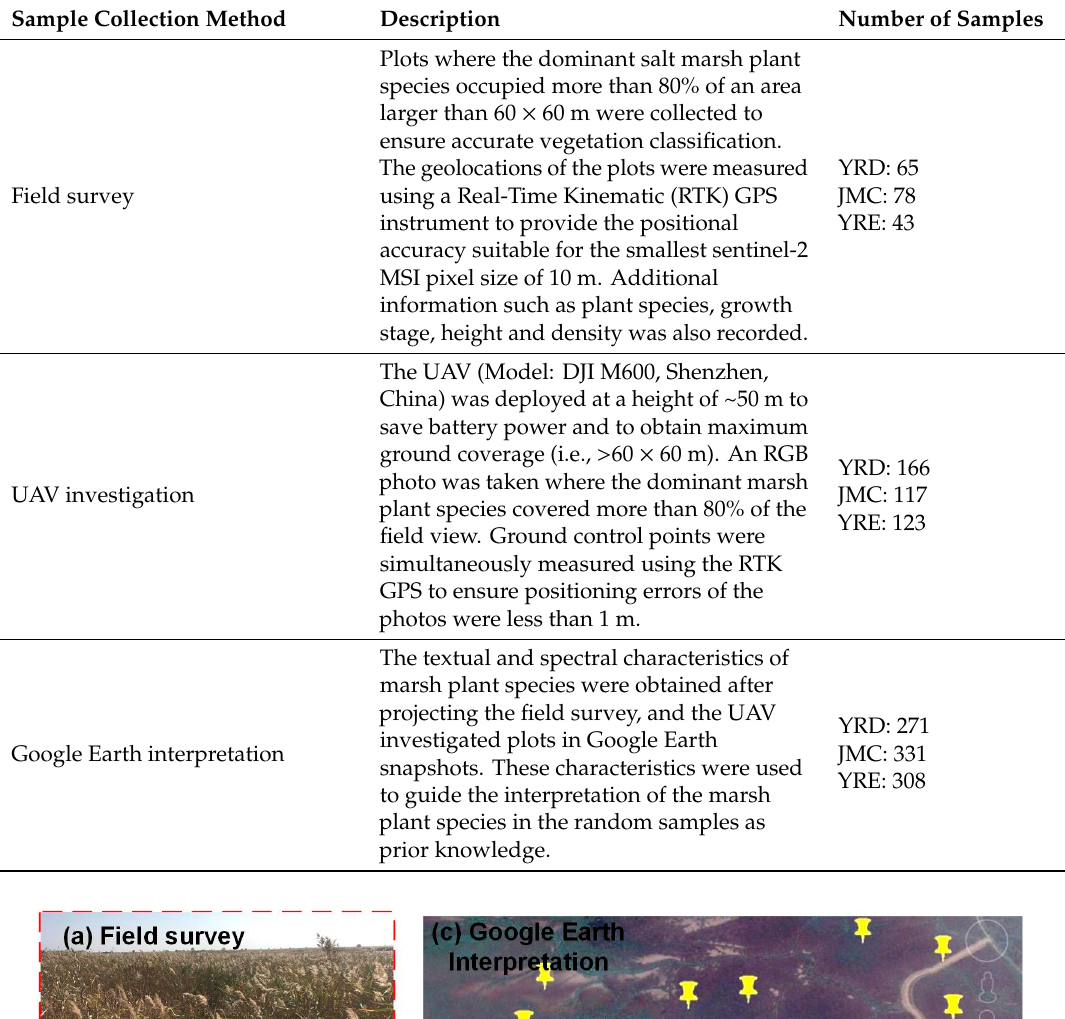
Table 1. Sample collection methods in relation to the classification of salt marsh vegetation.